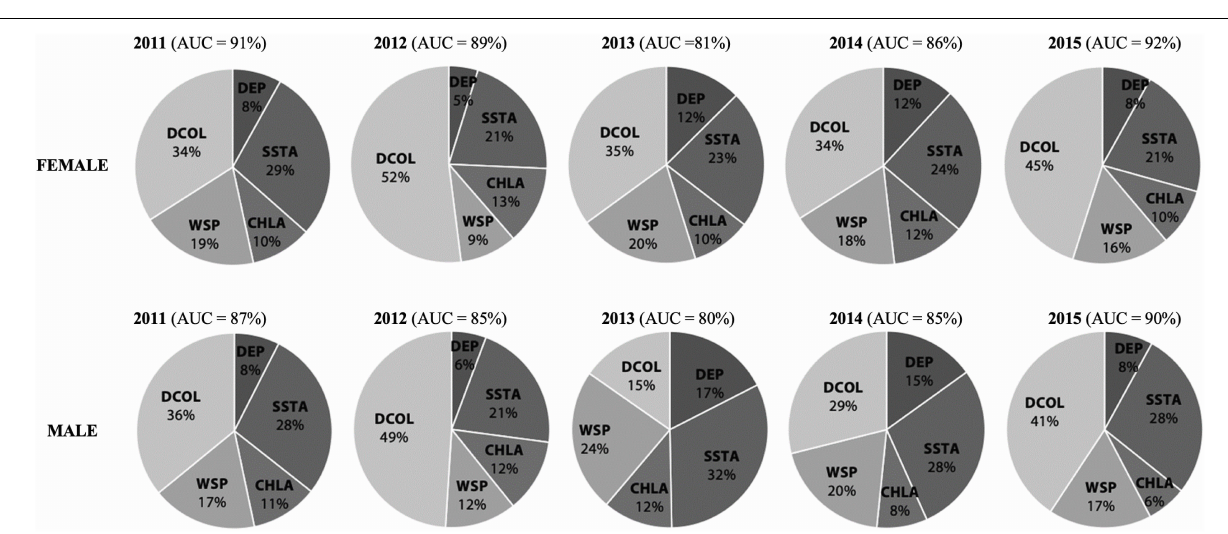
FIGURE 3 | Percentage contributions of environmental predictors from the MaxEnt habitat models to the foraging distributions (locations inside 50% kernel utilization distribution [UD]) of female and male sooty terns from Ascension Island between 2011 and 2015. DCOL—distance to colony, DEP—ocean floor depth,